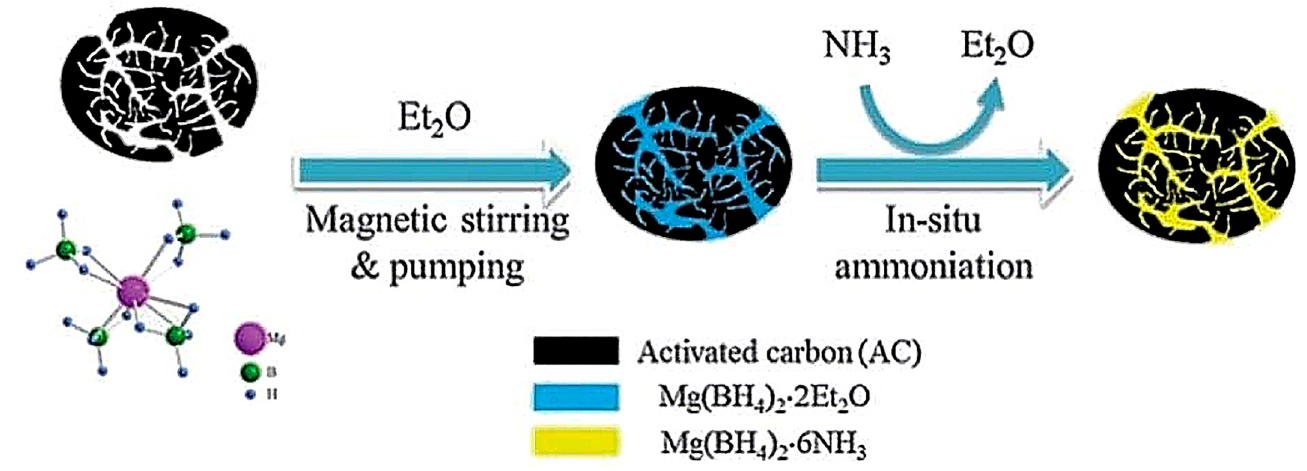
Figure 12. Schematic preparation procedure of the nanoconfined Mg(BH 4 ) 2 · 6NH 3 . Figure is reprinted with permission from [256].